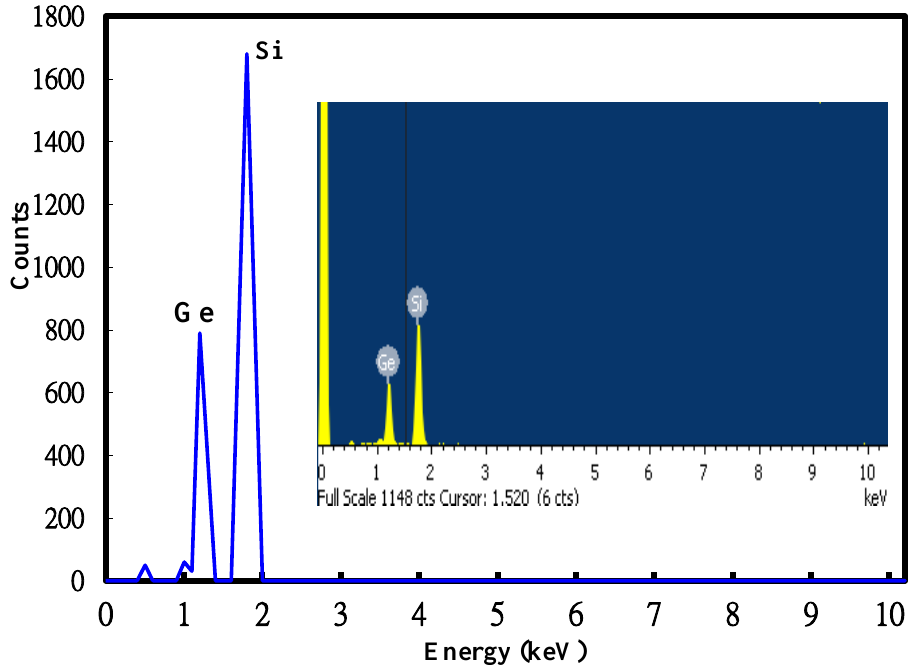
Figure 3. Energy dispersive X-ray spectrometer (EDS) analysis of the deposited Si 0.8 Ge 0.2